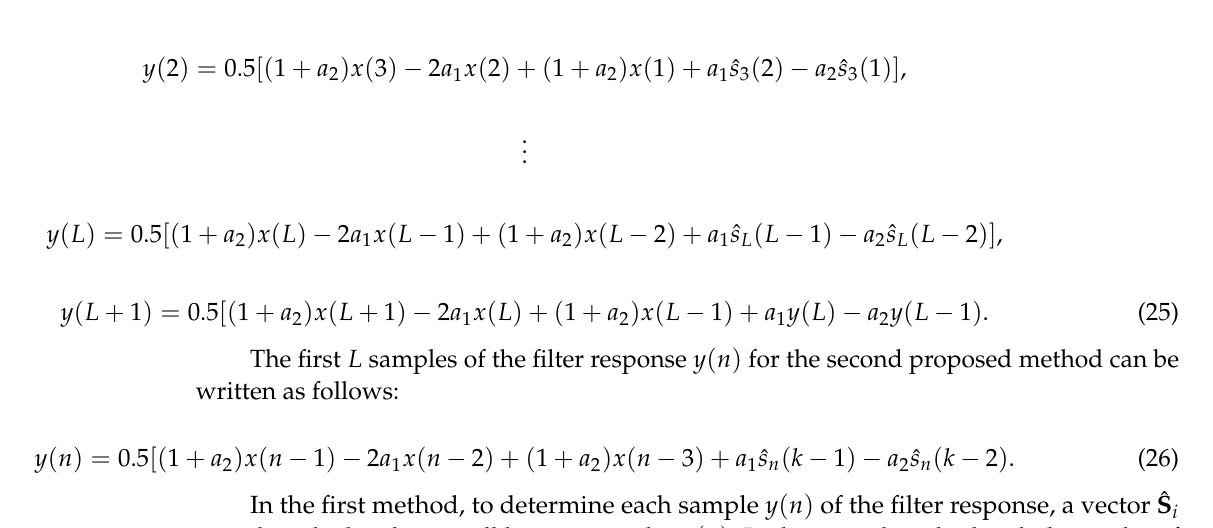
Table 1. Filtration quality indices for the case: L = 100, k = 5, Ω 0 = 50 Method for